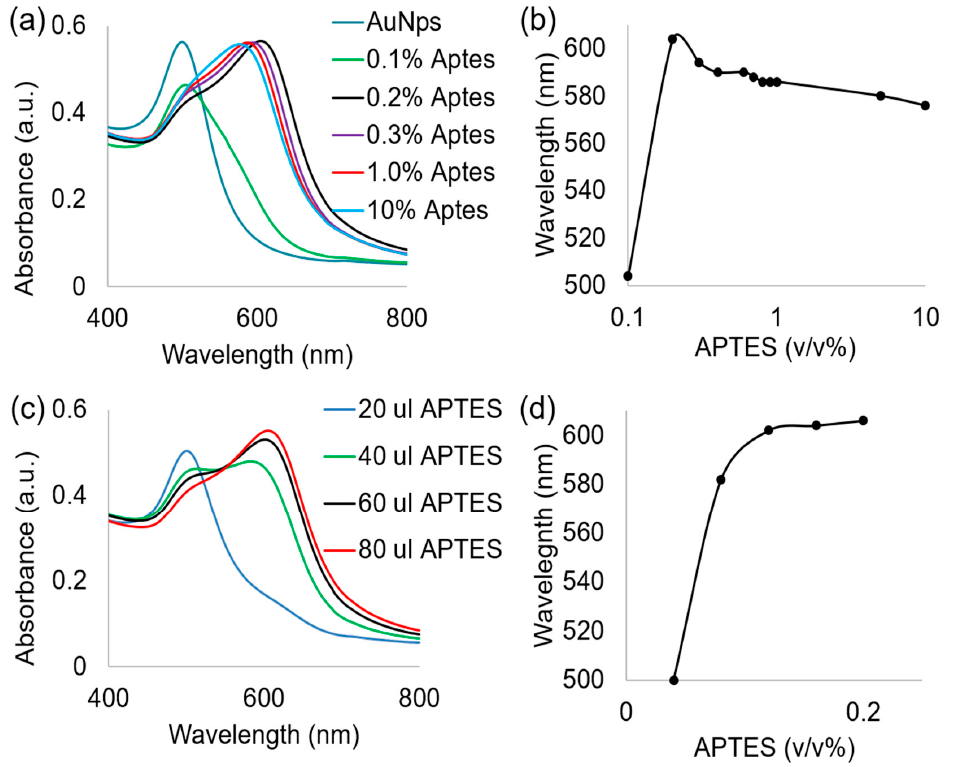
Figure 7. Displays the ultraviolet visible absorbance spectra of ferritin and AuNp system exposed to APTES and the absorbance peak wavelength as a function of the APTES concentration. ( a , b ) 0.1–10% APTES and ( c , d ) 0.04–0.2% APTES for denatured and non-denatured ferritin